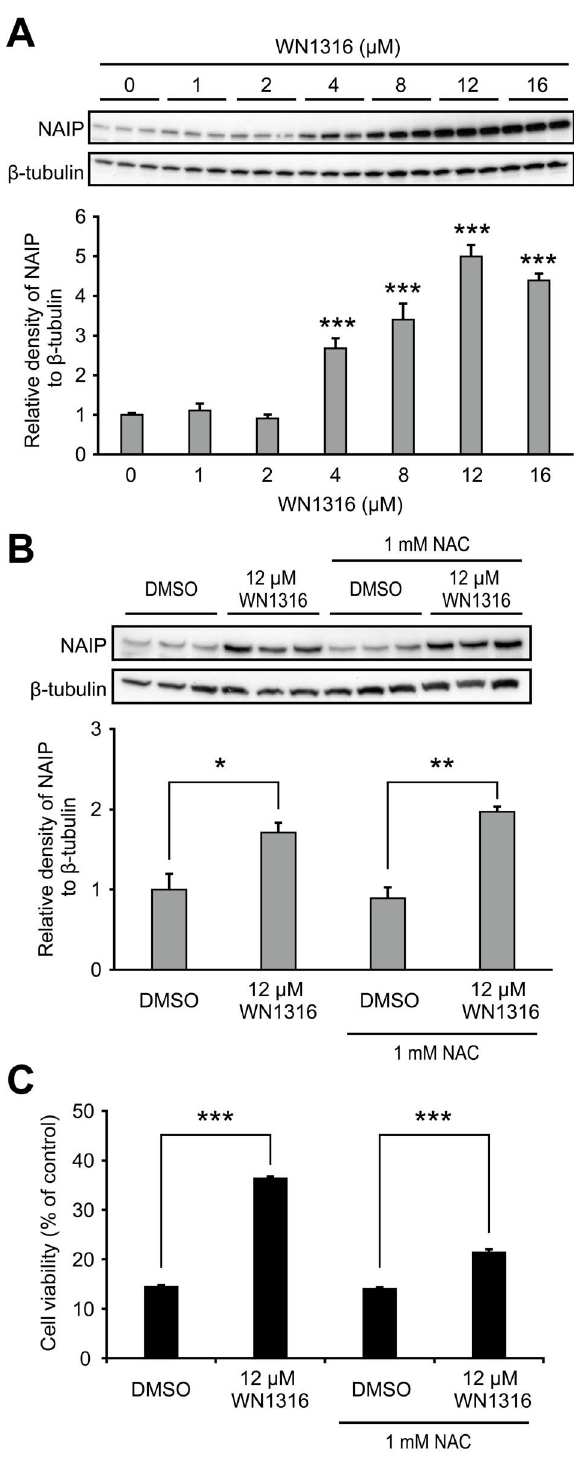
Figure 3. WN1316 upregulates endogenous NAIP. (A) Western blot analysis of NAIP in a WN1316 dose-dependent manner. THP-1 cells were incubated with 1 to 16 m M 1316 for 24 h. Cell lysates were analyzed with anti-NAIP antibody. b -tubulin was used as a loading control for protein. Densitometric data for NAIP bands was normalized by the level of b -tubulin. Data are expressed as mean 6 SEM (n=3). *** p , 0.001 by one-way ANOVA with Dunnett’s post hoc test compared with untreated control. (B) Western blot analysis of NAIP in N - acetylcysteine (NAC)-treated THP-1 cells. Cells were incubated